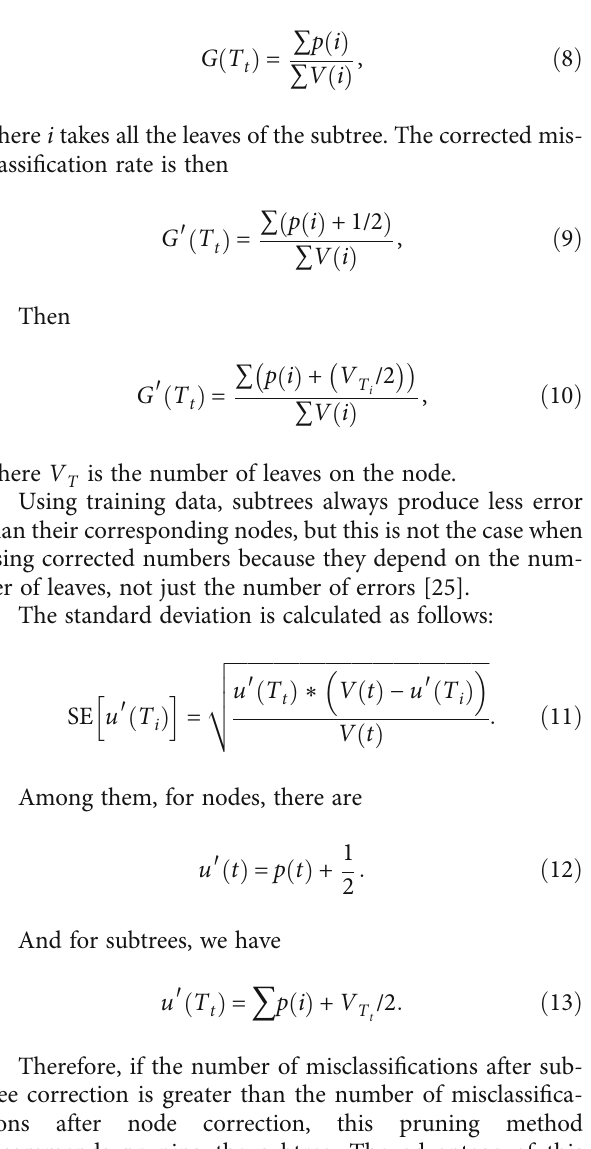
Table 1: Decision tree construction